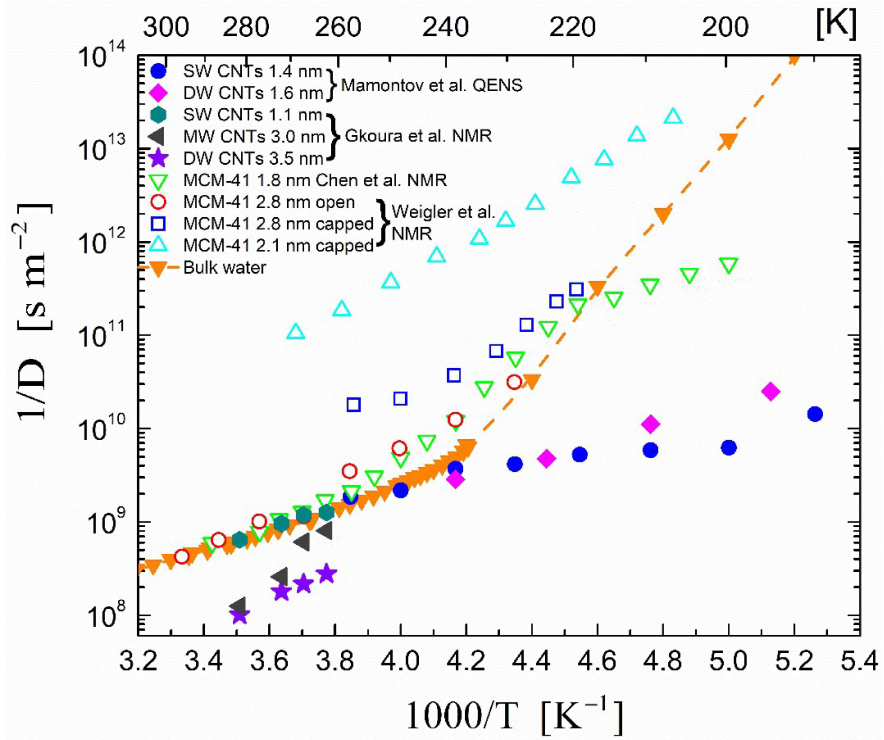
Figure 3. Temperature dependence of the inverse self-diffusion coefficient in supercooled confined H 2 O. The orange line represents a guide to the eye for the available experimental data for bulk H 2 O presented in Section 2.1 (filled inverted triangles ( ▼ )). Filled circles ( ● ) and filled diamonds ( ) repre- sent the self-diffusion coefficient ( D ) obtained from QENS experiments of H 2 O confined in single- and double-walled carbon nanotubes, respectively (Mamontov et al. [73]). Filled hexagons ( ), dark grey triangles ( ), and stars ( ) are the D values of H 2 O confined in SW 1.1 nm, MW 3.0 nm, and DW 3.5 nm, respectively, acquired via 2D D - T 2 static field gradient NMR experiments (Gkoura et al. [74]). Inverted open triangles ( ) are the self-diffusion coefficients obtained from the pulsed field gradient NMR experiments of water confined in MCM-41 (Chen et al. [75]). Open circles ( ), open squares ( ), and open upright triangles ( ) are the self-diffusion coefficients obtained from static field gradient NMR experiments on water in open 2.8 nm, capped 2.8 nm, and capped 2.1 nm MCM-41 samples, respectively (Weigler et al. [76]).